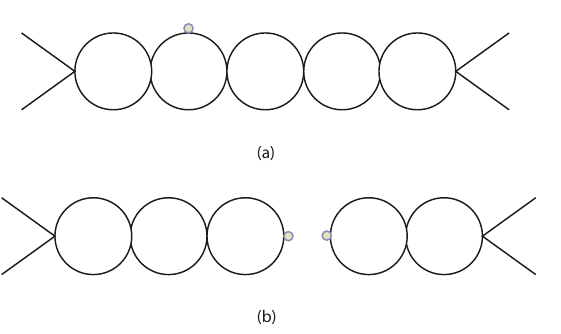
Figure 4 . The (cid:1) c 2 vertex.